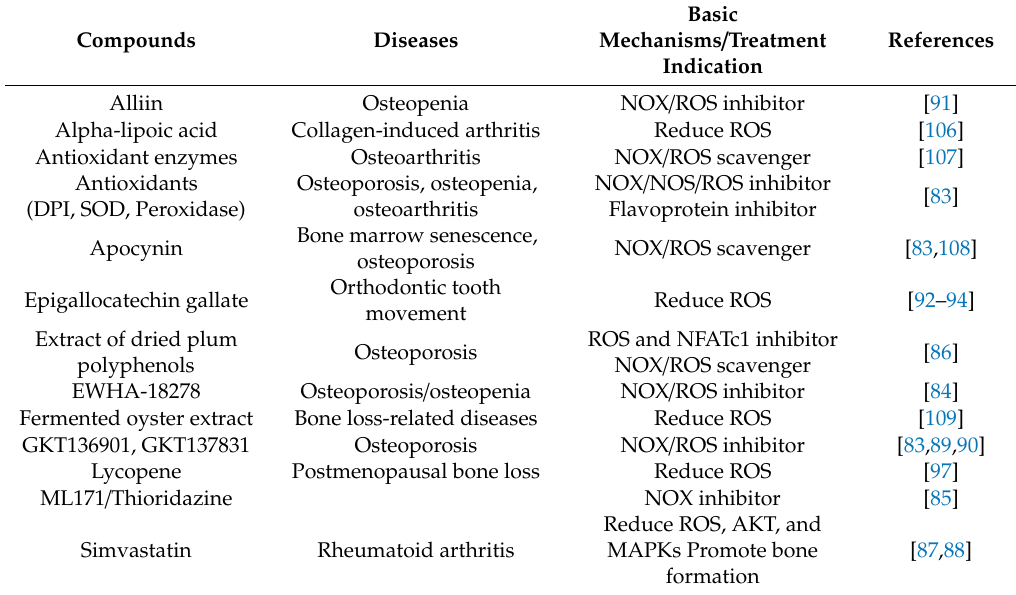
Table 2. ROS / NOX inhibitors: Basic mechanisms and treatment